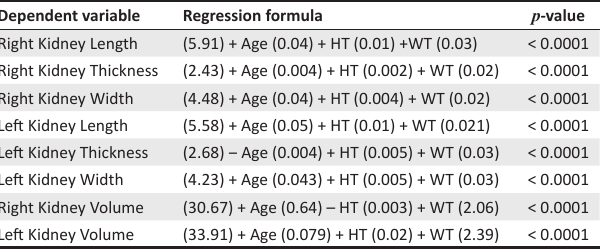
TABLE 5: Distribution of the regression formula for the various renal dimensions using age and body size